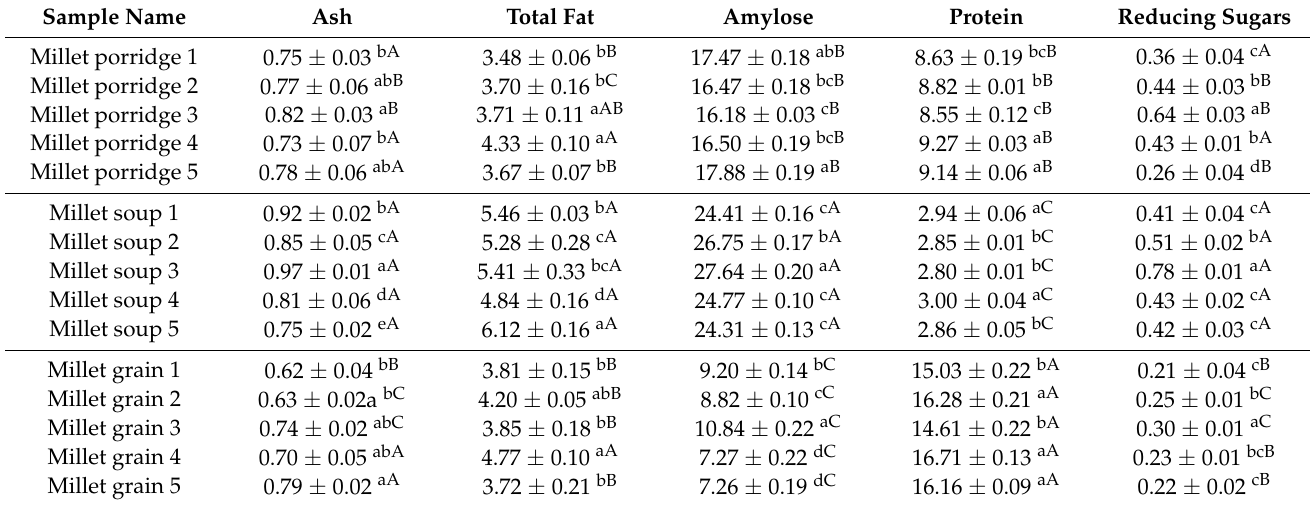
Table 3. Content of basic components of millet preparations cooked in different electric